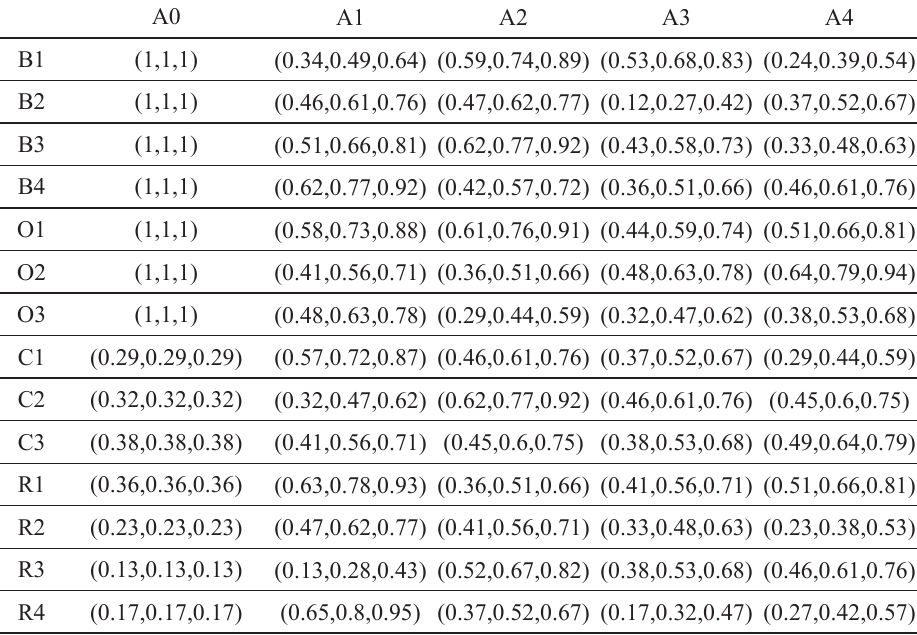
Table 11. Aggregated evaluation